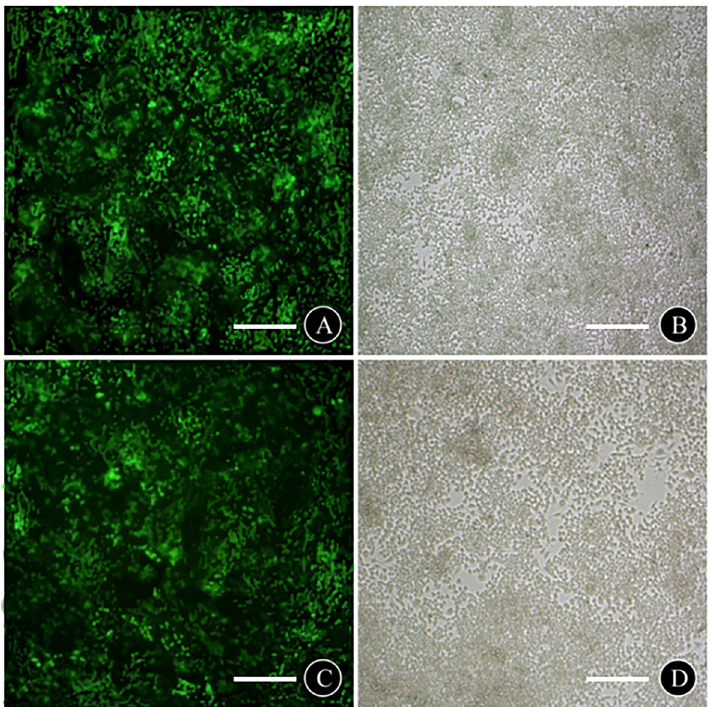
Figure 1. Transfection ef fi ciency of cells in PI3K-RNAi and mTOR-RNAi groups after 72 h transfection. A , PI3K-RNAi fl uorography; B , PI3K-RNAi white light graph; C , mTOR-RNAi fl uorography; D , mTOR-RNAi white light graph. Scale bar, 100 m m.